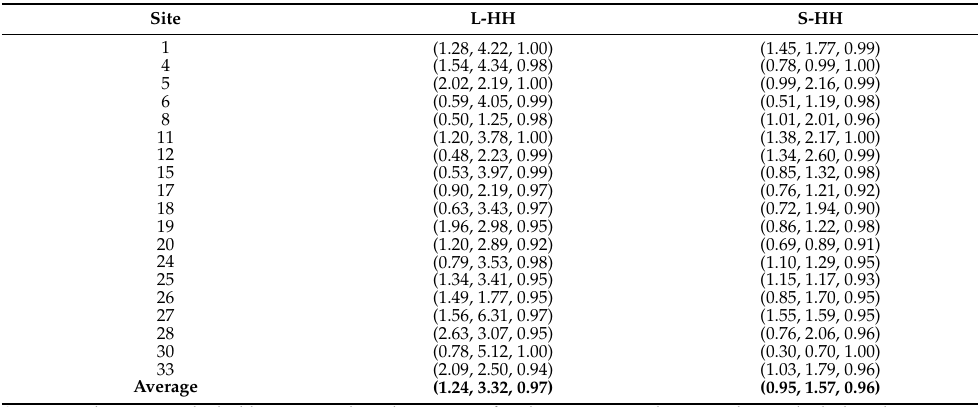
Table 3. Forward Model Comparison of Backscattering at 21 Corn Fields; Within parenthesis are ubRMSE, RMSE, and